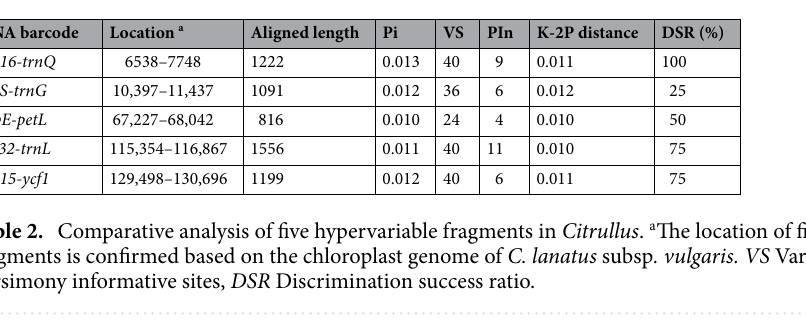
DNA barcode Location a Aligned length